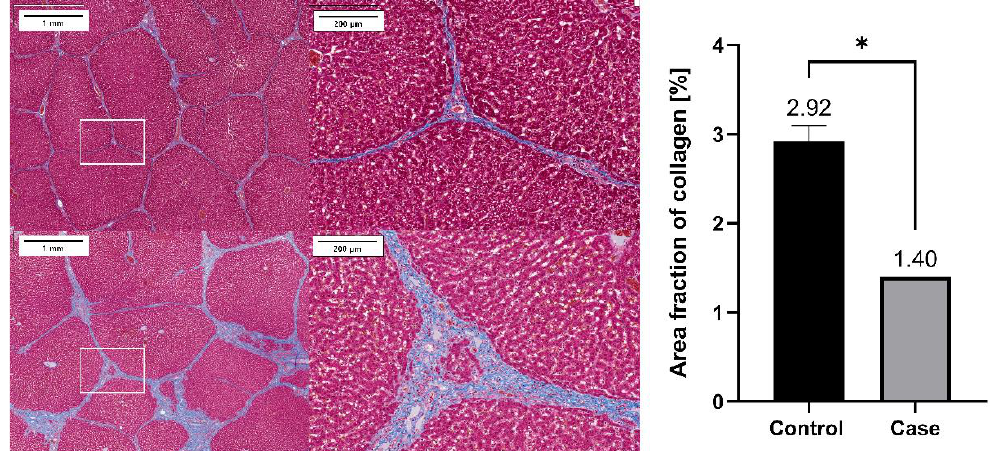
Figure 8. Representative histopathological images of the MT staining of the liver sections harvested from the case group ( upper ) and the control group ( below ). Percentage area of collagen (% of positively stained area) was compared between the control ( n = 3) and case ( n = 1) groups, which showed significant difference (*, p < 0.05) between the control and case groups ( p = 0.019 ). MT: Masson’s Trichrome staining.